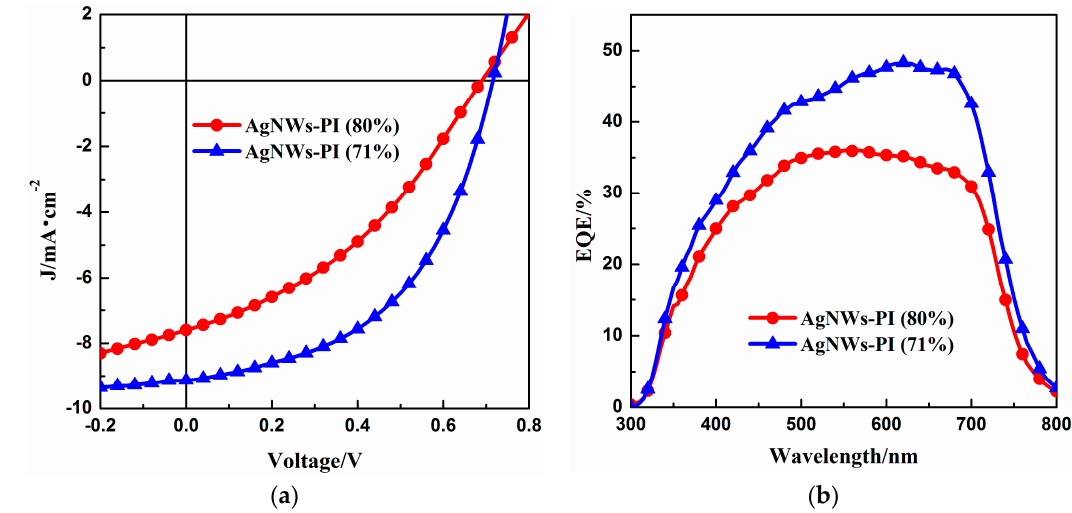
Figure 6. J-V characteristics ( a ) and EQE (external quantum efficiency) spectra ( b ) of the solar cells based on the Ag NWs-PI transparent electrodes with transmittances of 80% and 71%, respectively. Table 1. Photovoltaic characteristics of the solar cells based on the Ag NW-PI (Ag nanowire-polyimide) transparent electrodes with transmittances of 80% and 71% under AM 1.5G illumination.